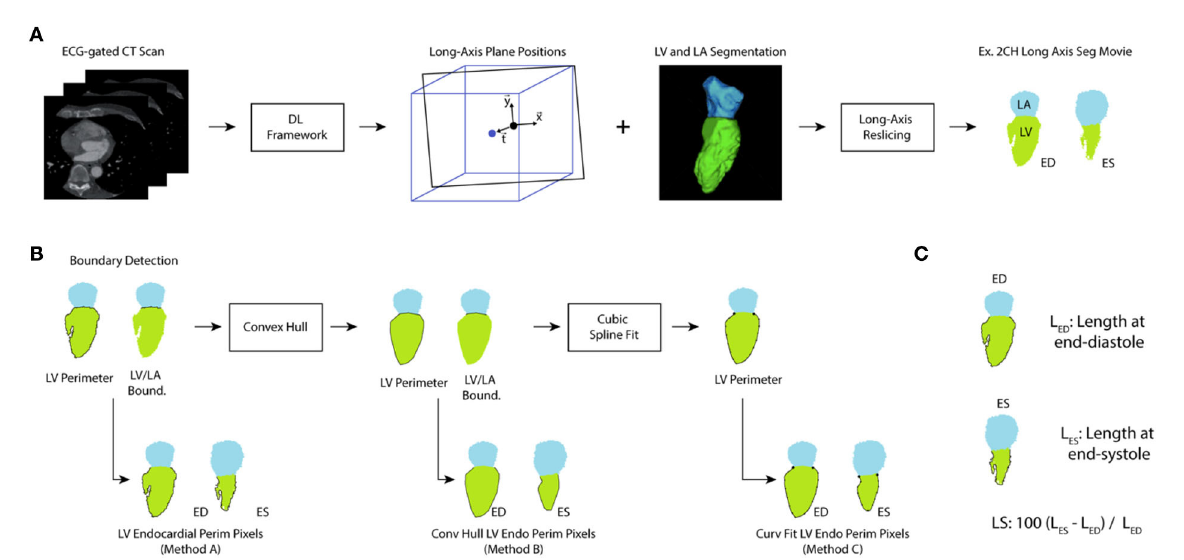
FIGURE2 Processing of ECG-gated CT for evaluation of LS. (A) ECG-gated volumes are analyzed using a deep-learning (DL) framework that provides the location of the 2-chamber, 3-chamber, and 4-chamber long axis planes and delineates the LV and LA blood pools. From this information, long-axis slices of the segmentations were created throughout the cardiac cycle. (B) The perimeter of the left ventricle and the LV/LA boundary pixels were identified and used to extract the LV perimeter. Method A did not perform any additional processing of the perimeter. However, a convex hull was applied to correct for papillary muscle artifacts (leading to Method B). Further, a cubic splint was fit to the result of the convex hull to correct for variations in texture (Method C). (C) For each long-axis view and each analysis method, the length of the perimeter was measured at end-diastole (the timeframe with largest LV volume) and end-systole (the timeframe with smallest LV volume) and used to calculate